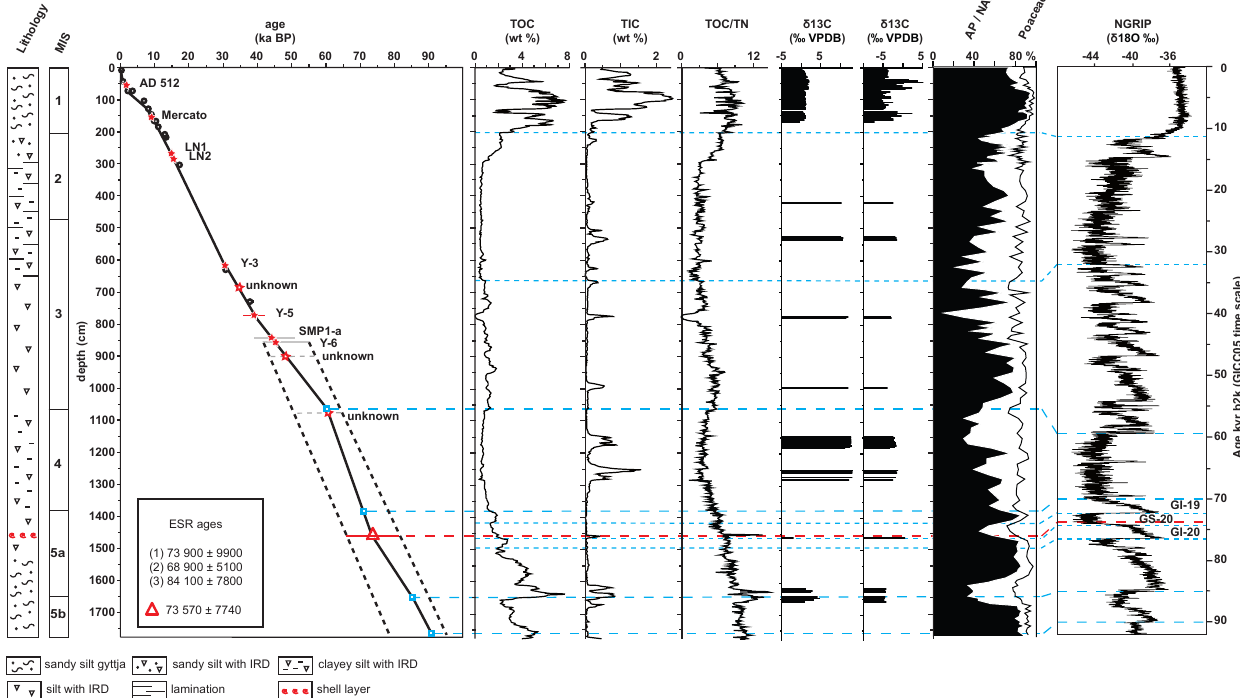
Fig. 2. Age model, lithology and selected data sets from core Co1215 from Lake Prespa (data from Damaschke et al., 2013; Wagner et al., 2012; Leng et al., 2013; Panagiotopoulos et al., 2013b). Chronological tie points are indicated by black dots (radiocarbon ages), red stars (tephras; open stars were not used for the age–depth model), and blue squares (cross correlation with NGRIP). The oxygen isotope data set from NGRIP (North Greenland Ice Core Project members, 2004) is based on the Greenland Ice Core Chronology 2005 (GICC05) timescale (GICC05modelext, 2010 and references therein). GICC05 ages are given in units of b2k (years before 2000AD). Dashed lines indicate tie points of core Co1215 with NGRIP-GICC05, modified after Damaschke et al.